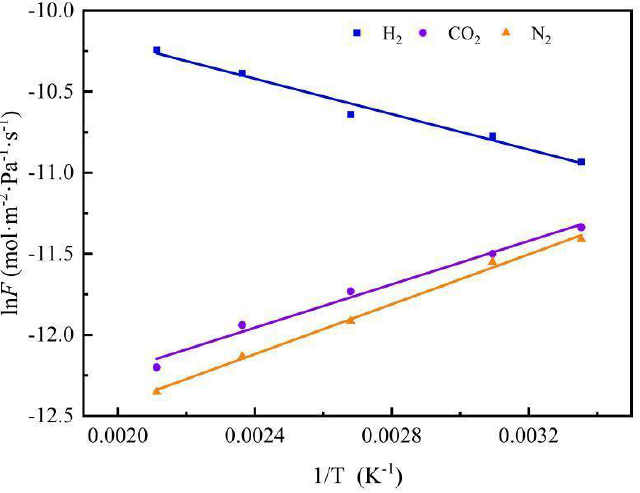
Figure 16. Arrhenius plots of gas (H 2 , CO 2 , and N 2 ) permeances in Nb/SiO 2 membrane with n Nb = 0.08 at a pressure difference of 0.1 MPa.